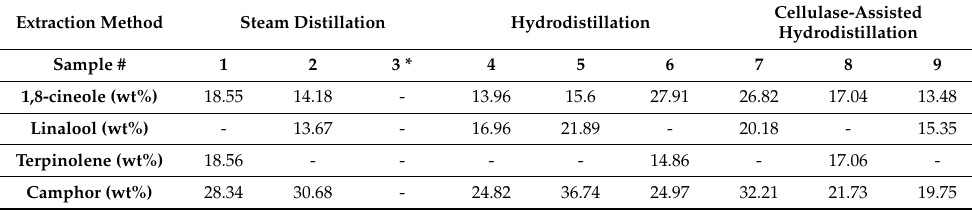
Table 1. Composition of oil samples extracted using three different methods. Extraction Method